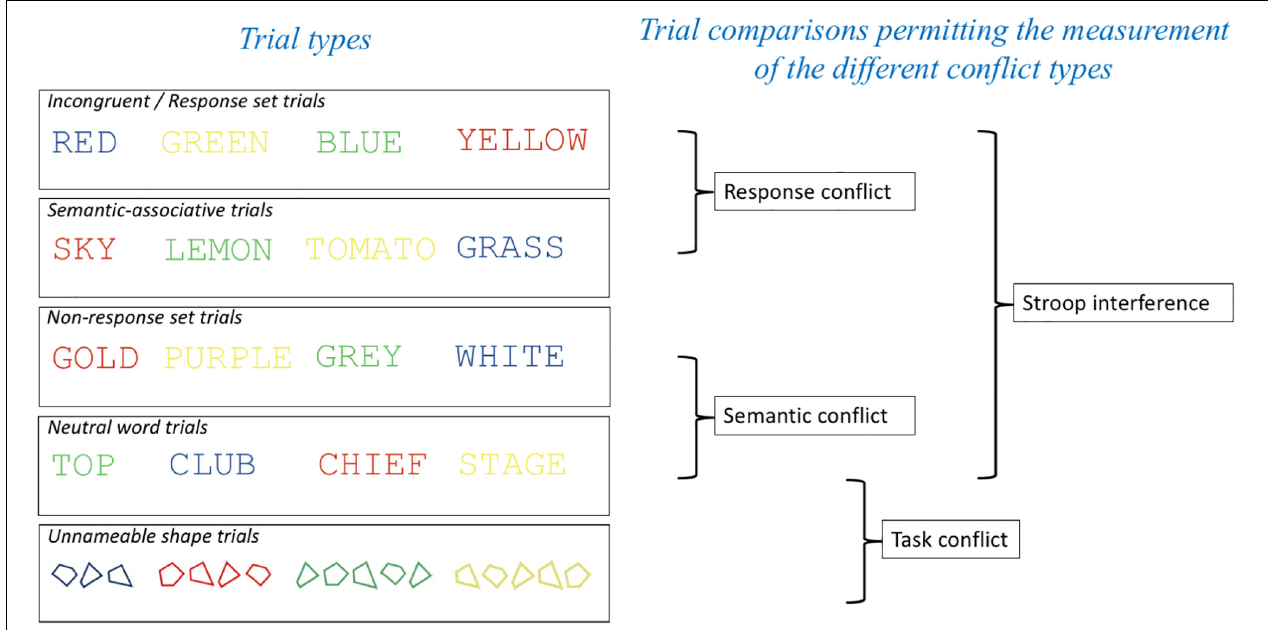
FIGURE 1 | Trial types employed and comparisons made in the experiment to enable the indexing of the different conflict types in the Stroop task. Having two separate trial types that permit the measurement of semantic conflict without response conflict (Semantic-associative and Non-response set trials) meant that our measurements of response conflict [Incongruent (response set) – Semantic-associative] and semantic conflict (Non-response set and Neutral word trials) were orthogonal to each other.